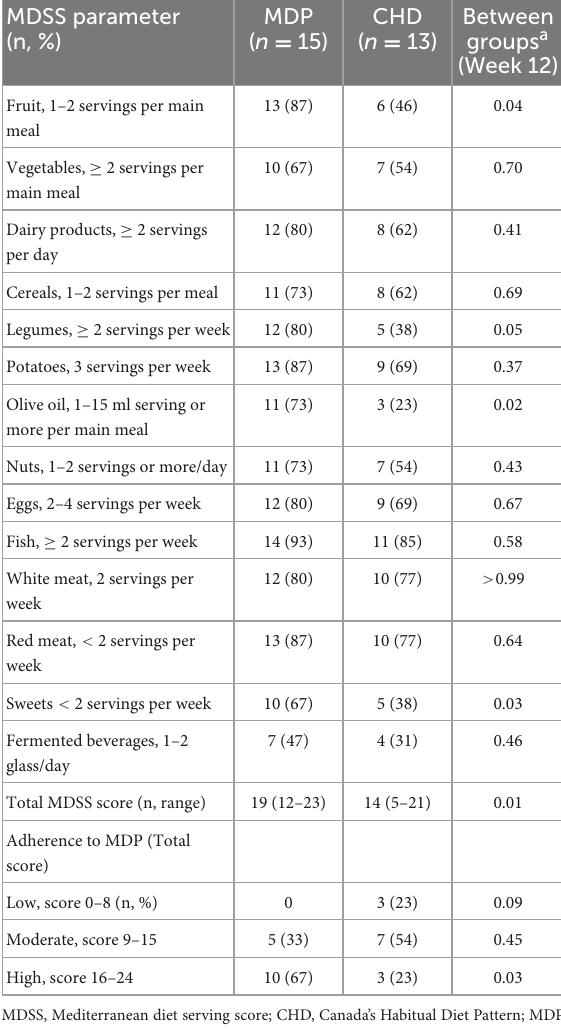
TABLE 4 The Mediterranean diet serving score for the Mediterranean diet pattern at baseline and week 12. MDP CHD Between MDSS parameter ( n = 15) ( n = 13) groups a (n, %)